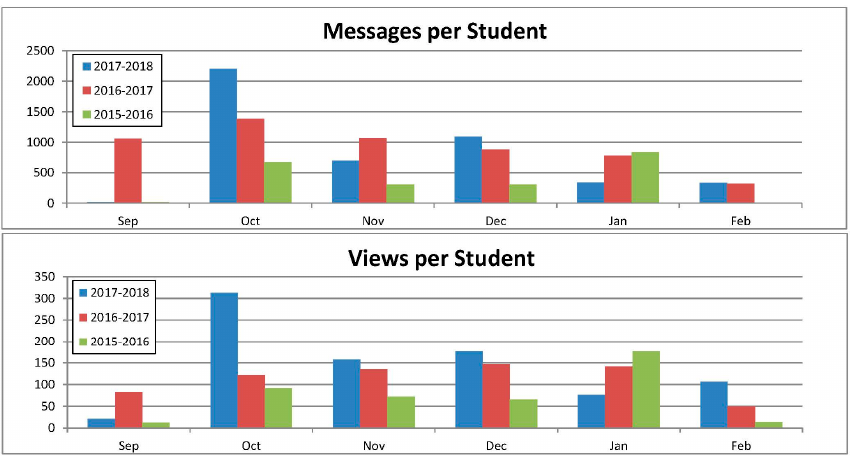
Figure 2. Global activity in Moodle